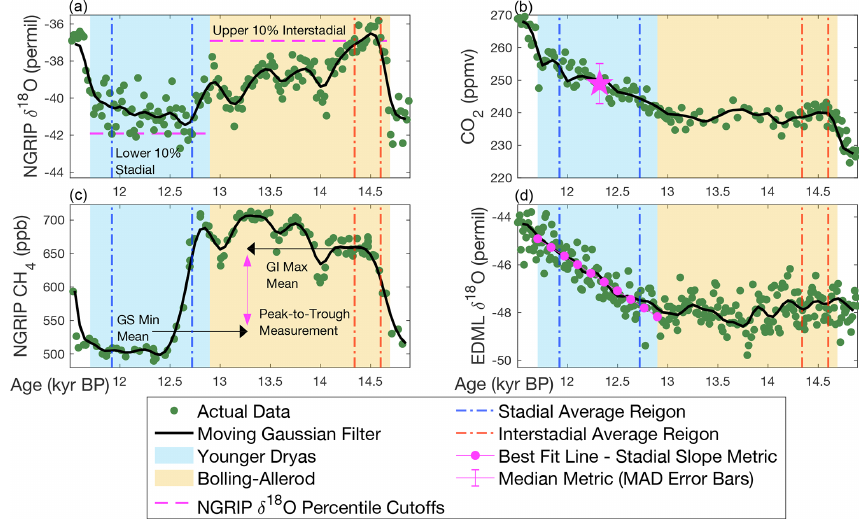
Figure 3. Three metrics for capturing the shape and location of D–O cycles across multiple paleoclimate records. In all panels, raw data are presented in green, while interpolated data using a 300-year moving Gaussian filter (250 years for CO 2 , given the sparsity of data at points) are presented in black. Blue and orange background shading represents stadial and interstadial conditions, respectively, while pink arrows and symbols demonstrate the three measurements taken: in the NGRIP δ 18 O panel (a) , the extreme 10% percentiles of the δ 18 O data are determined, and the time window into which all such data fall are extracted (blue represents stadial and red interstadial vertical average regions). The difference in the means of each record’s data within these time windows for any given D–O cycle constitutes our peak-to-trough measurement (shown in c for NGRIP CH 4 ). The OLS linear slope of the stadial data determines the stadial slope for each record in each D–O cycle (shown in the d for EDML δ 18 O). The third metric is the stadial median (shown in b with a star). The metrics are illustrated in individual panels for convenience, but all are applied to all